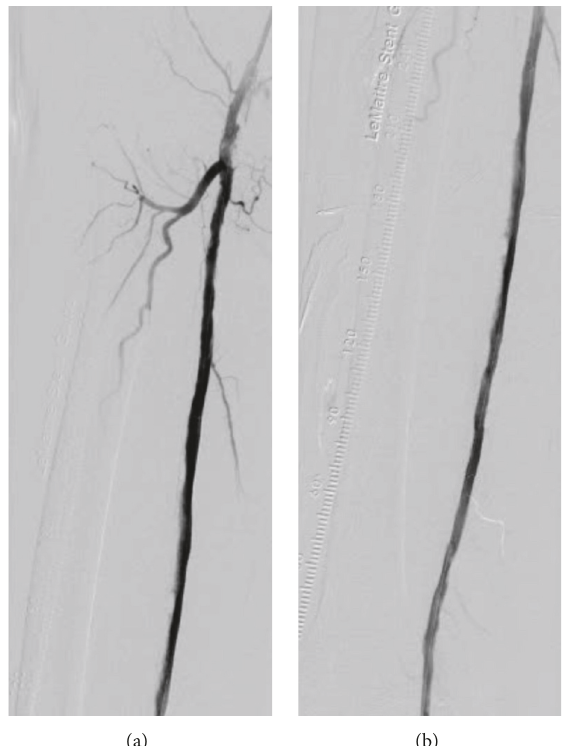
Figure 5: The final angiogram. (a) Digital subtraction angiography of the proximal superficial femoral artery. (b) Digital subtraction angiography of the distal superficial femoral